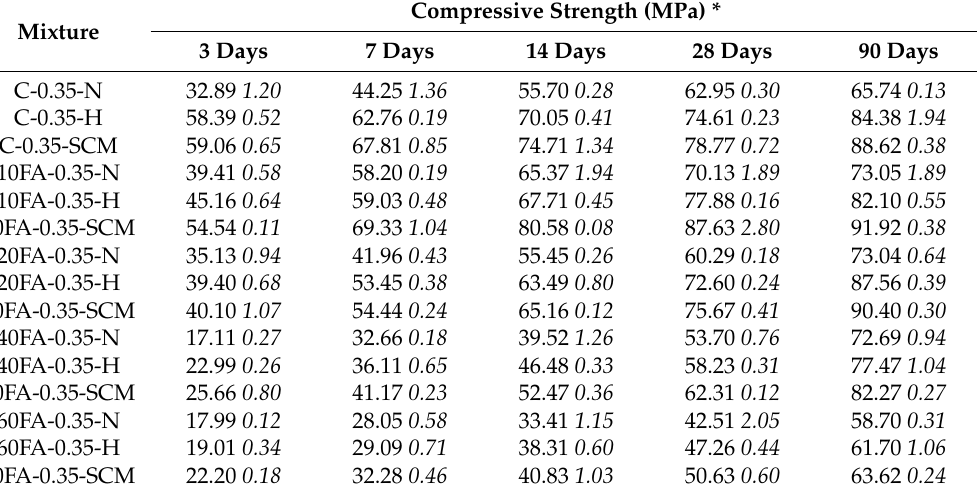
Table A1. Compressive strength for w/b 0.35.